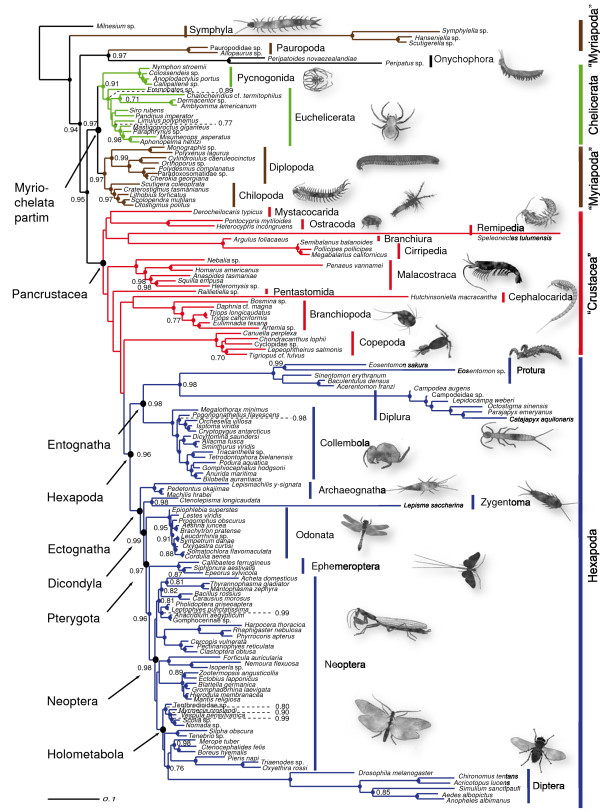
Time-heterogeneous consensus tree. Consensus tree from 56,000 sampled trees of the time-heterogeneous substitution process inferred by PHASE-2.0, graphically processed with Adobe Illustrator CS2. Support values below 0.70 are not shown (nodes without dots), nodes with a maximum posterior probability (pP) of 1.0 are represented by dots only. Quotation marks indicate that monophyly is not supported in the given tree.